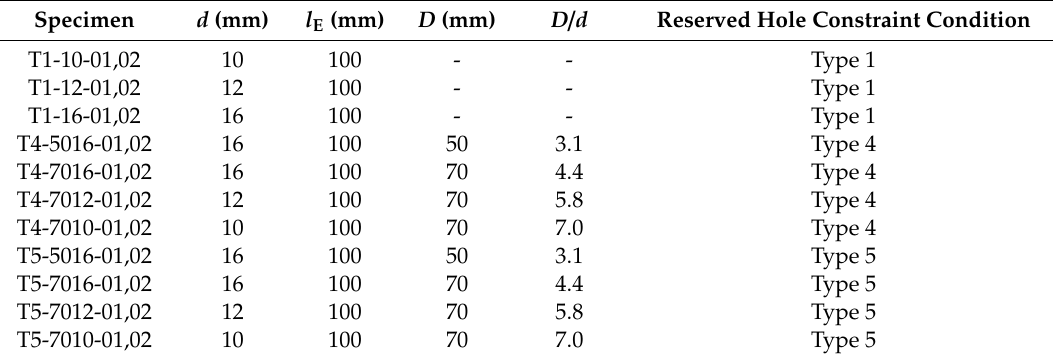
Table 1. Key information of